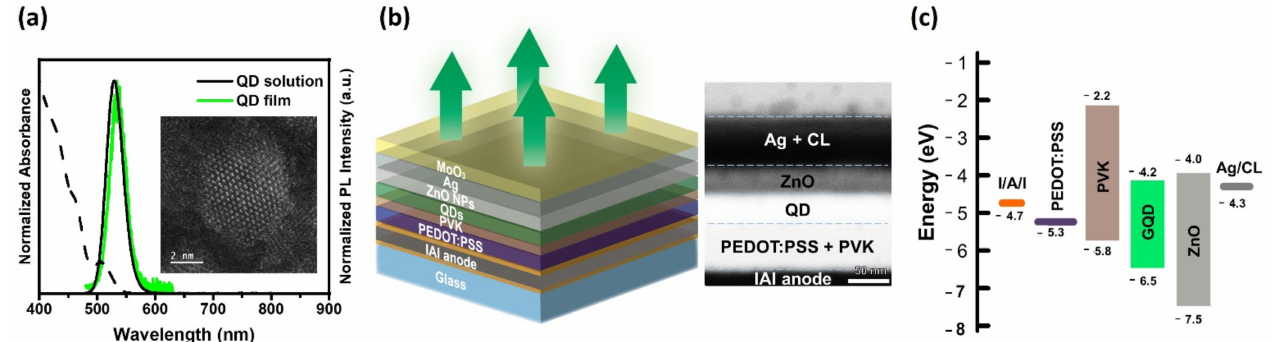
Figure 3. ( a ) The normalized PL and absorption spectra of QDs in the solution form (octane) and film form (spin-coated on a glass). The inset shows a TEM image of a QD (5.8 ± 0.8 nm). ( b ) Schematic diagram and cross-sectional TEM image of the TEQLED device structure in this study. ( c ) The energy level diagram of the TEQLED. The QD conduction band and valence band energies were estimated from UPS and optical absorption spectra. The values of the other layers were adopted from the literature [43,44].